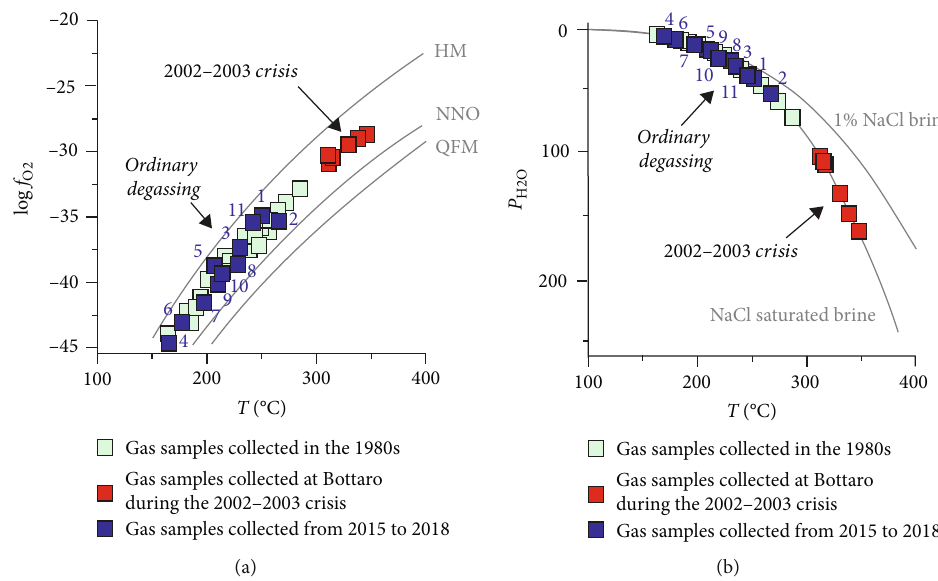
Figure 3: Geothermometric and geobarometric estimations (see the text for further details) of the bubbling gases collected at Panarea in the 1980s (data after [17]), during the 2002-2003 volcanic crisis (data after [40]), and from 2015 to 2018 (this paper). (a) Temperature vs. oxygen fugacity (expressed as Log fO ) diagram. The solid bu ff ers quartz-fayalite-magnetite (QFM), nickel-nickel oxide (N-NO), and hematite- 2 magnetite (HM) are plotted as reference (after Eugster and Wones [78]). (b) Estimated equilibrium pressure of the hydrothermal reservoirs. The pressure is shown on the vertical axis as P (bars). The boiling curves for saturated NaCl and 1% NaCl waters (brines) H2O is calculated by using the estimated equilibrium are shown. P H2O